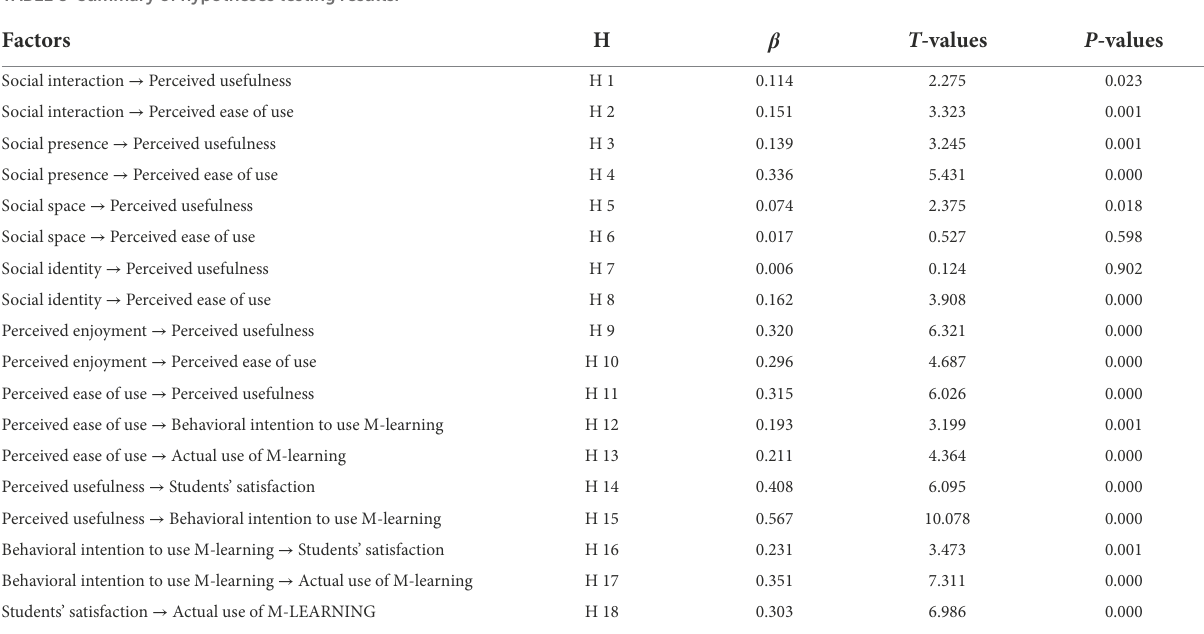
FIGURE 2 The findings for path coefficient.